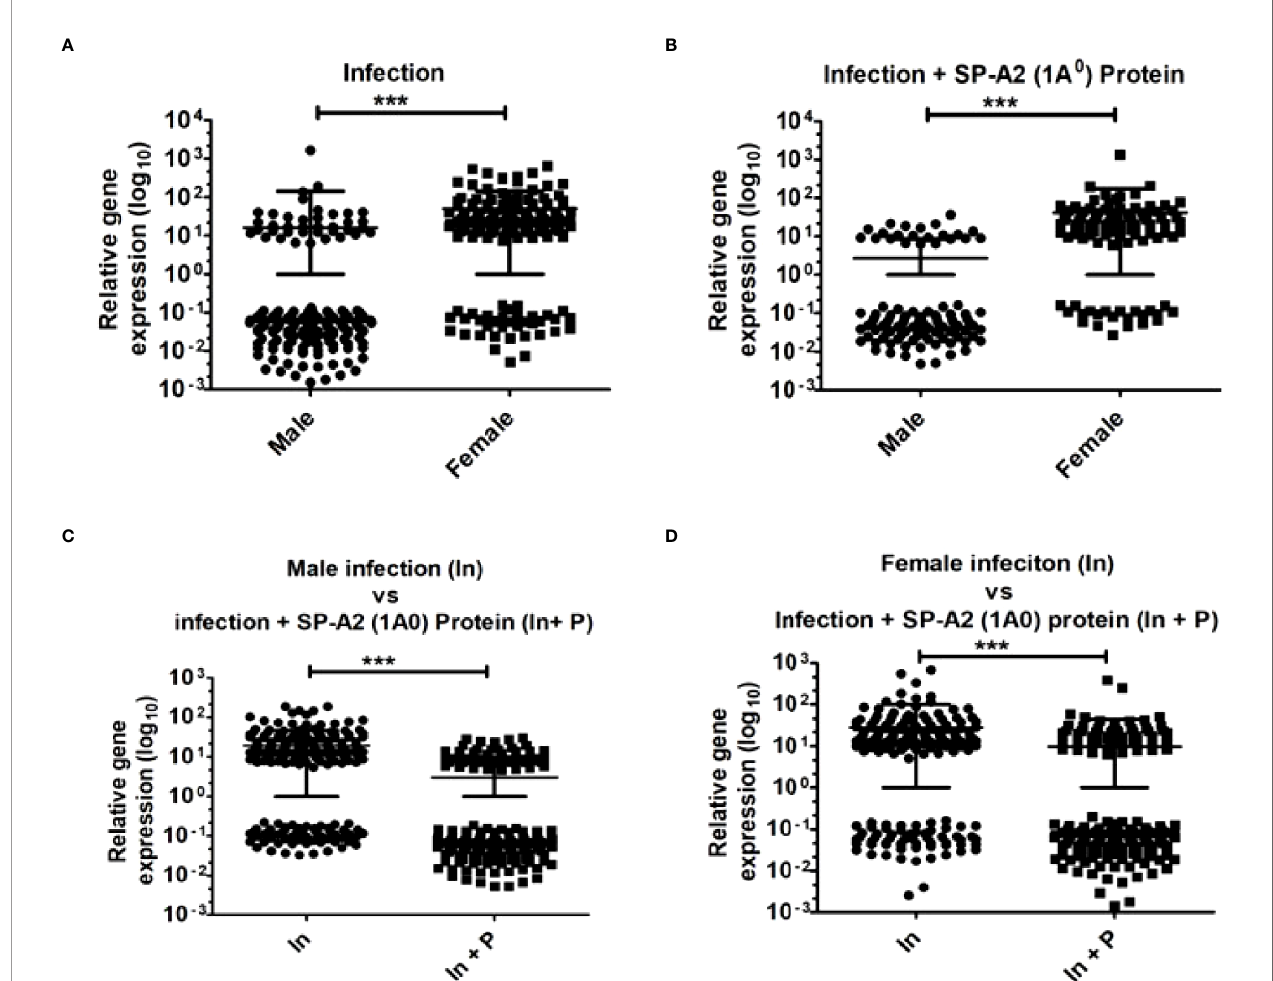
FIGURE 5 | Gene expression in KO mice of both sexes at 6 h after K. pneumoniae infection and infection plus SP-A2 (1A 0 ) protein rescue. A total of 169 genes in M vs. F after infection (A) , 105 genes in M vs. F after infection plus SP-A2 (1A 0 ) protein rescue (B) , 245 genes in male mice of infection vs. infection plus SP-A2 (1A 0 ) protein rescue groups (C) , and 188 genes in female mice of infection vs. infection plus SP-A2 (1A 0 ) protein rescue groups (D) were changed signi fi cantly and used in these analyses. These comparisons (n = 4/group) were signi fi cant (p < 0.05). Sex and treatment differences (***p < 0.001) were observed under studied